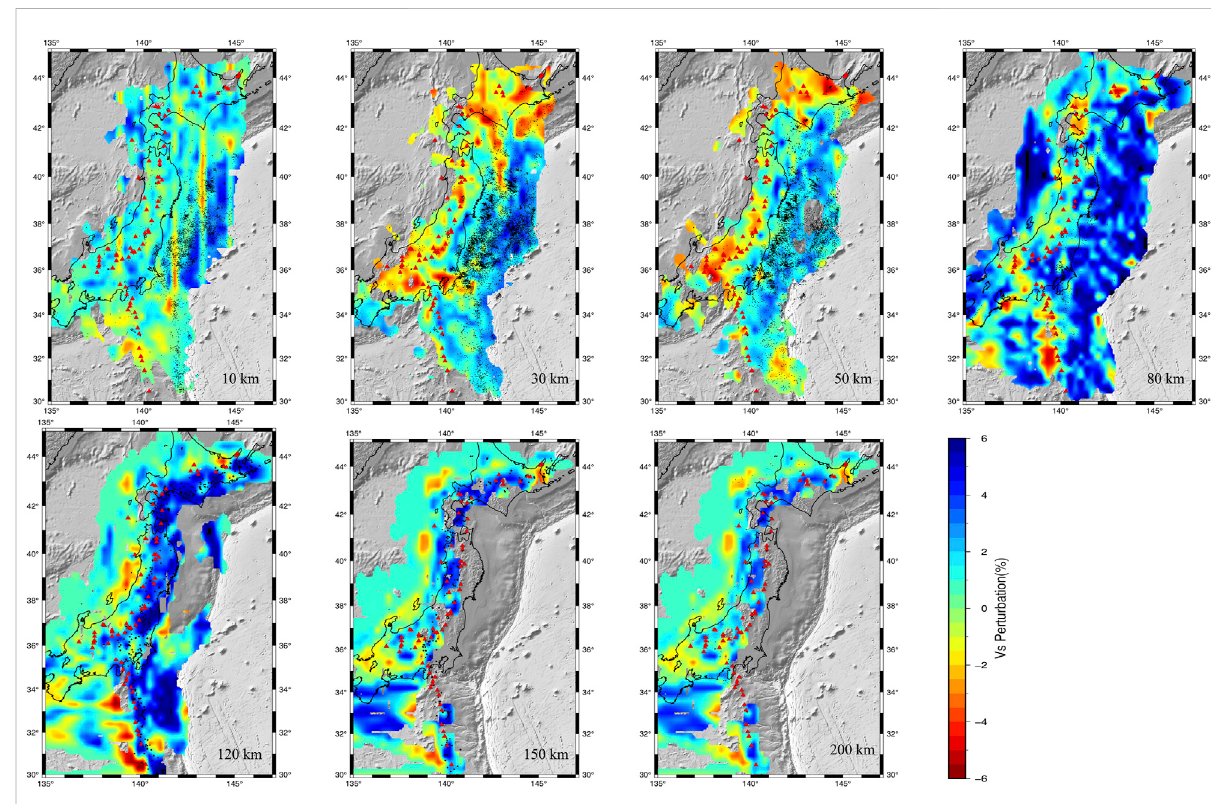
FIGURE 9 Map views of Vs structures. Black circles denote the background earthquakes that occurred within a layer of 30 km thickness bound to each slice. The red triangles denote the active arc